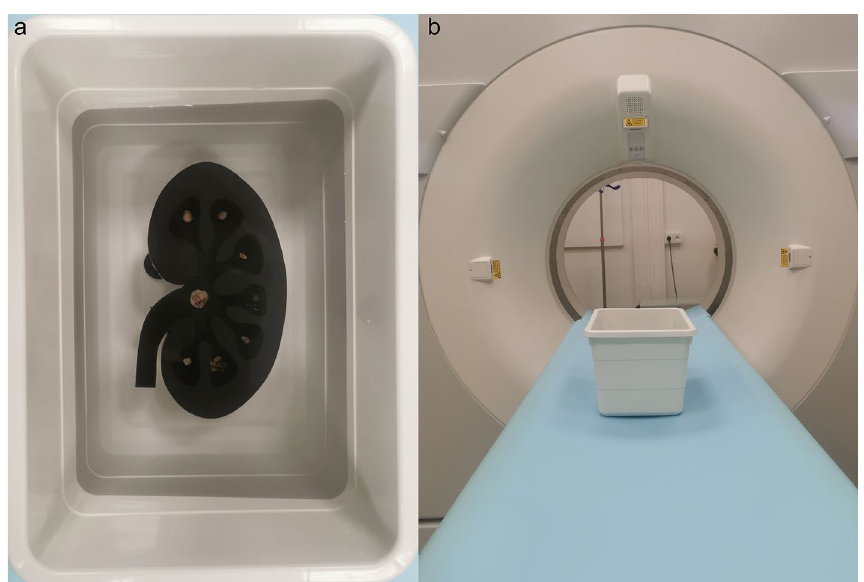
Figure 1. Semi-anthropomorphic phantom with kidney stones placed in a plastic box filled with water. Subsequently, CT scans were performed using a CTDI vol of 2 mGy ( A , B